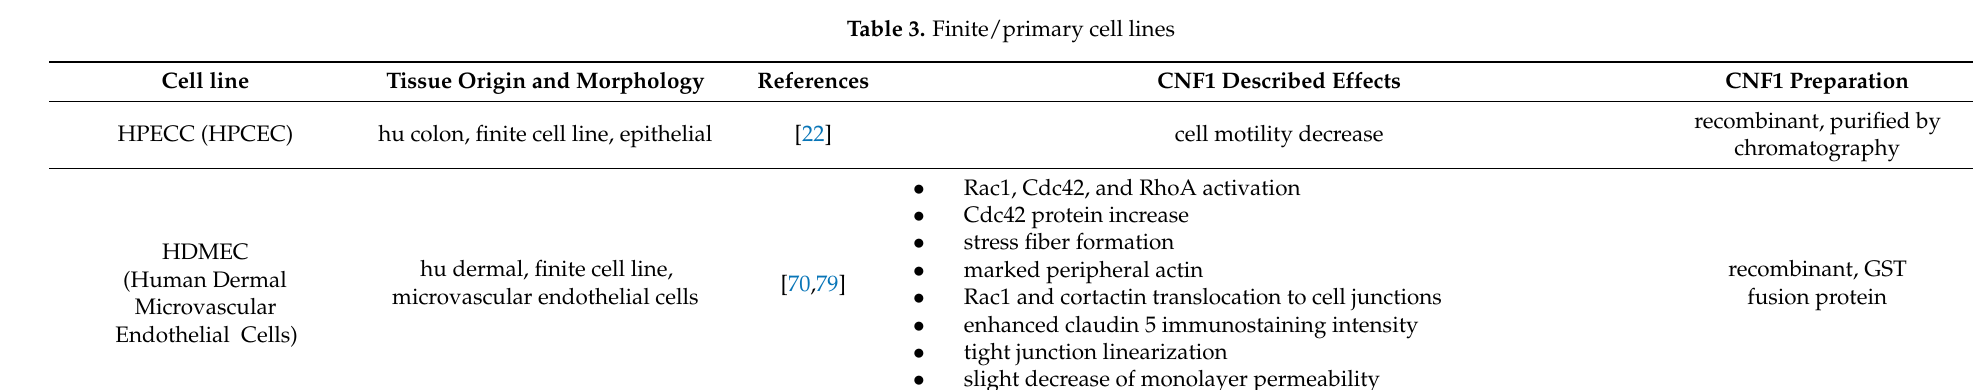
Table 3. Finite/primary cell